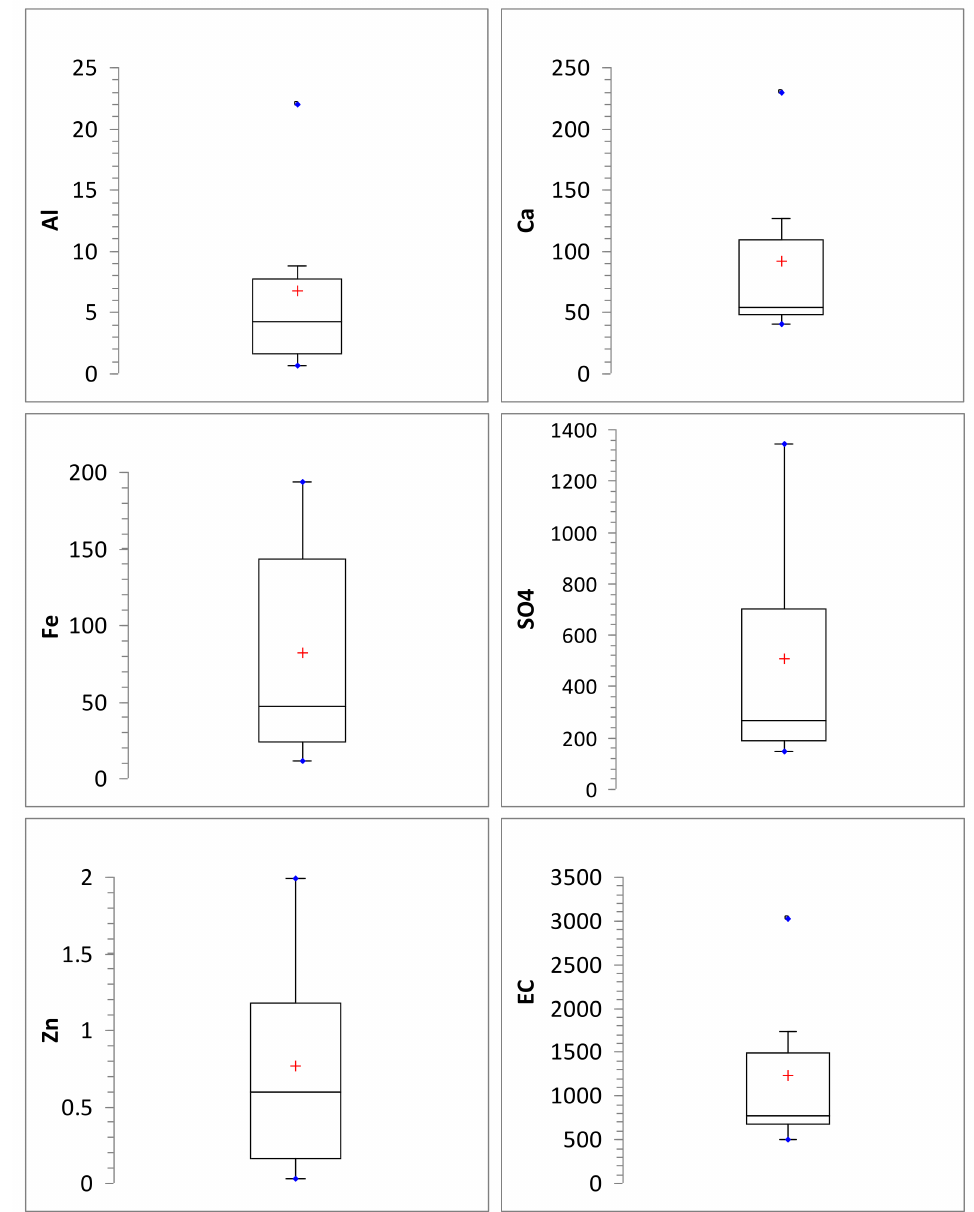
Figure 7. Distribution of major components in sampled water collected during the first campaign. PCA was performed using EC, Al, Ca, Co, Cd, Cr, Fe, Mg, Mn, Ni, Pb, SO 4 , Ti, Zn and pH as inputs and calculations were limited to three factors. The total percentage of the variance captured by these three factors corresponded to 98.99%; F1 = 87.5%, F2 = 6.4%, and F3 = 5.0% (see Table 3). Since F2 and F3 were lower than 10%, which is the minimum accepted value for hydrochemical groundwater analysis [40,45], they were not included in the PCA